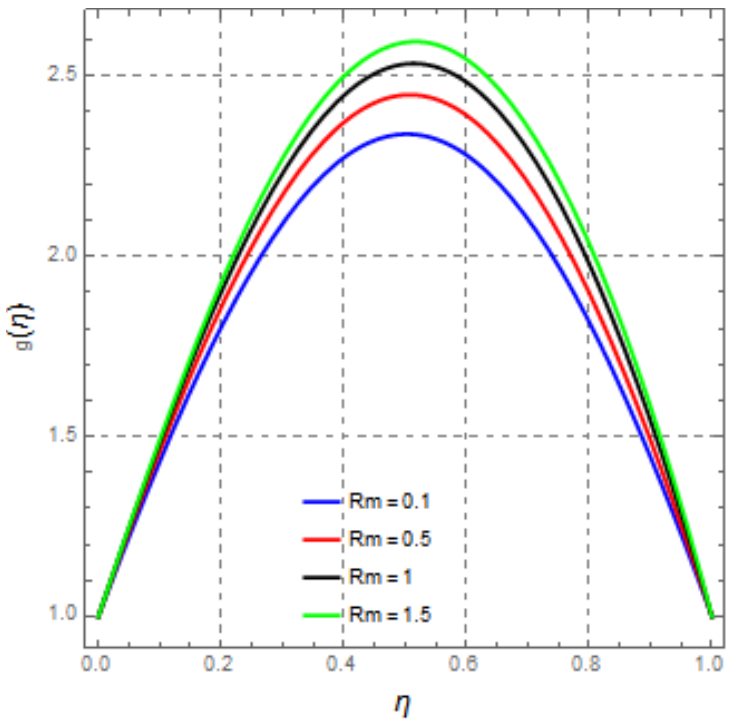
Figure 14. Impact of magnetic Reynolds number R m on velocity component g , keeping S z = − 1.5, M x = − 0.75, M y = 1, and S =